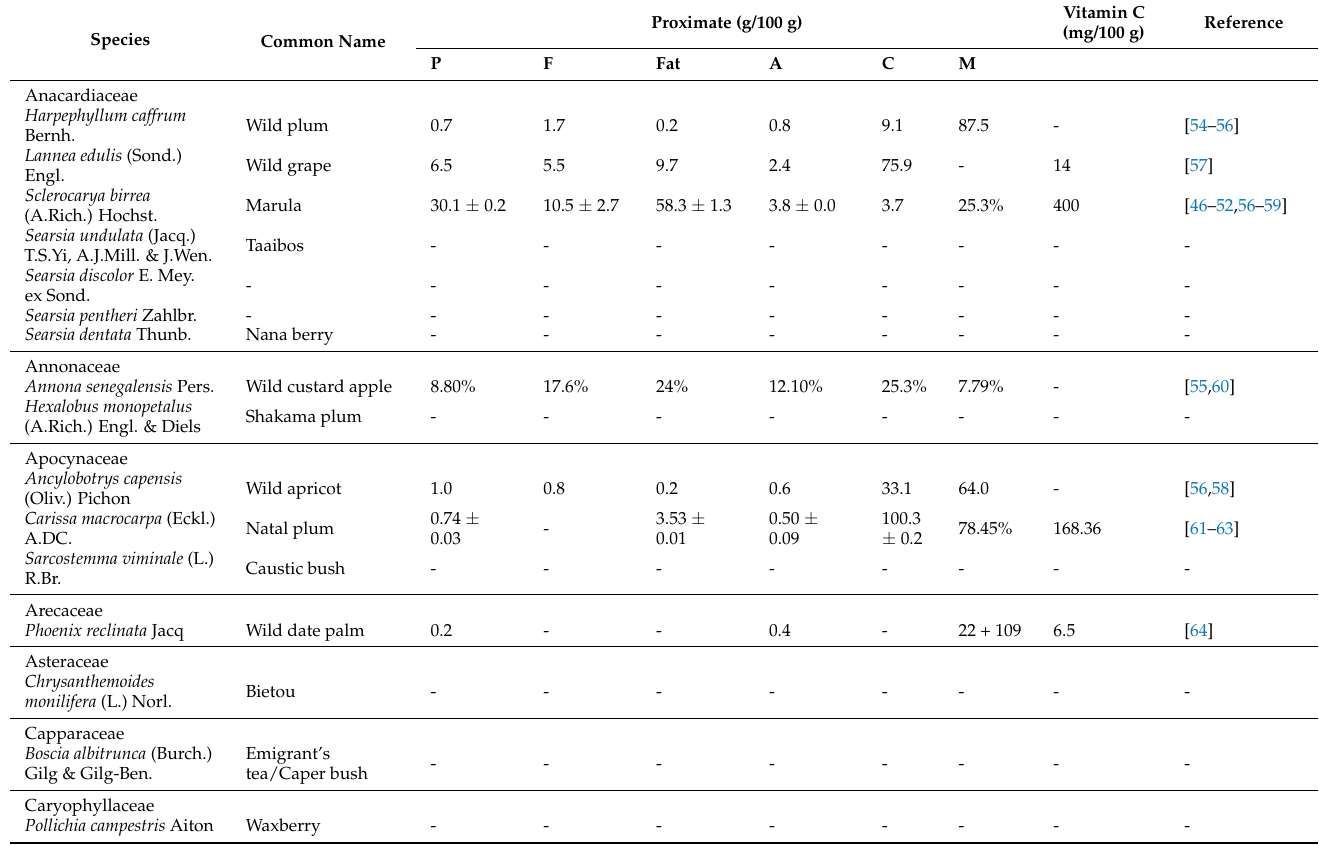
Table 1. List of wild indigenous Southern African plant species with edible fruits, their common names, known nutritional value, as well as